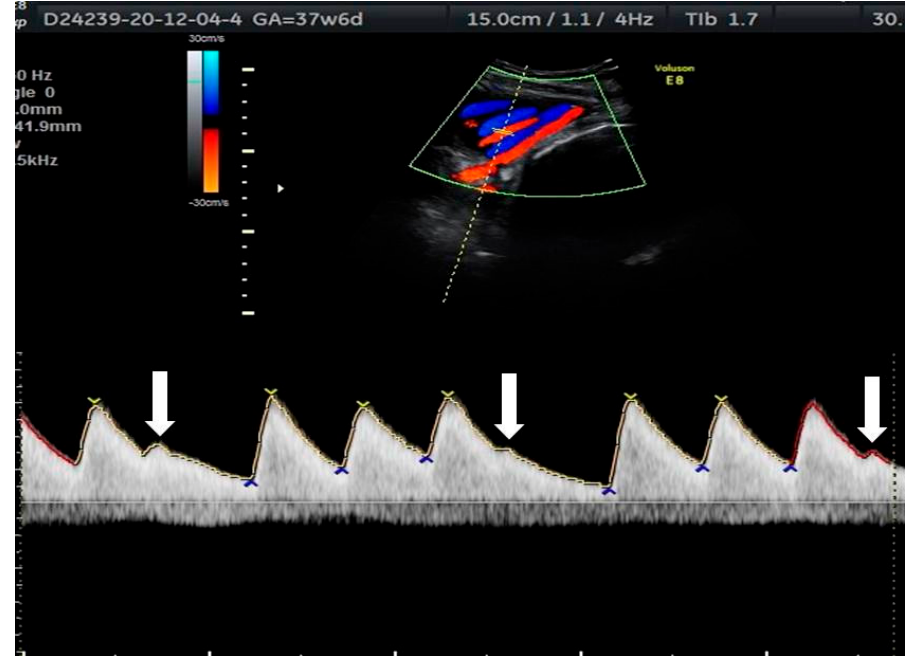
Figure 3. Atrial ectopic beats (indicated by arrows) on the umbilical artery Doppler waveform. Isolated ectopic beats are generally benign, regardless of the chamber of origin. Fetal Rarely, the irregular rhythm with normal heart rate can be caused by junctional or ventricular escape beats caused by sinus node dysfunction